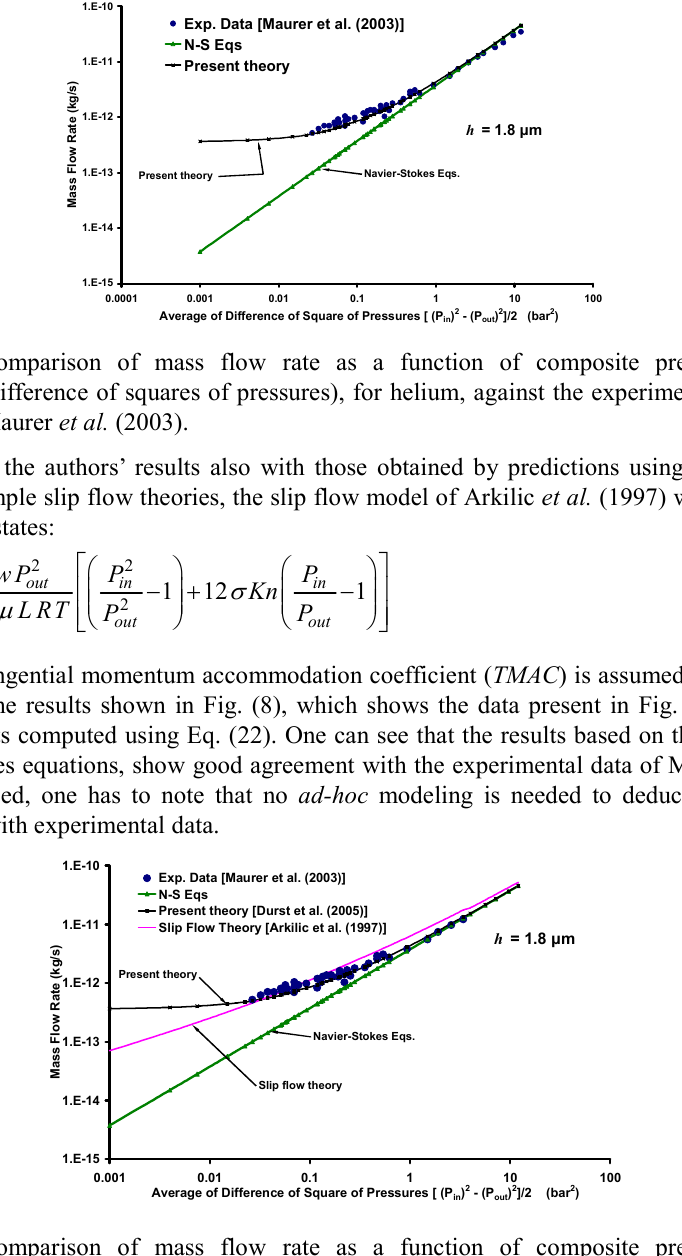
Fig. 8: Comparison of mass flow rate as a function of composite pressure drop (difference in squares of pressures), for helium, against the experimental data of Maurer et al. (2003) and the slip flow model of Arkilic et al.